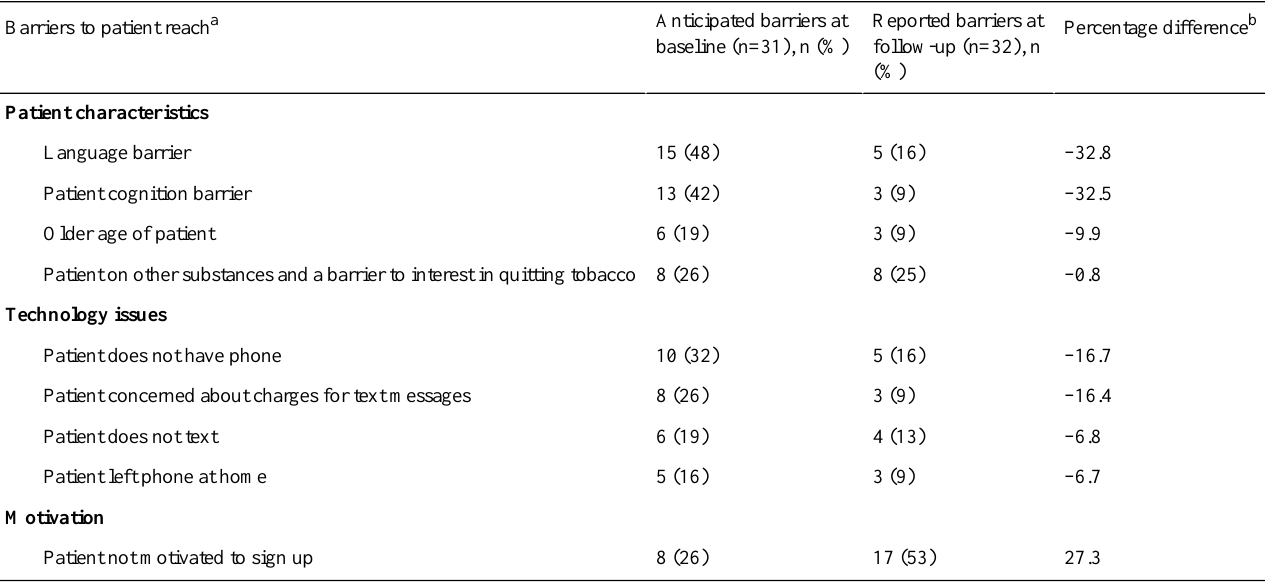
Table 1. Perceived and actual barriers to patient reach by nurses in the enhanced phase.